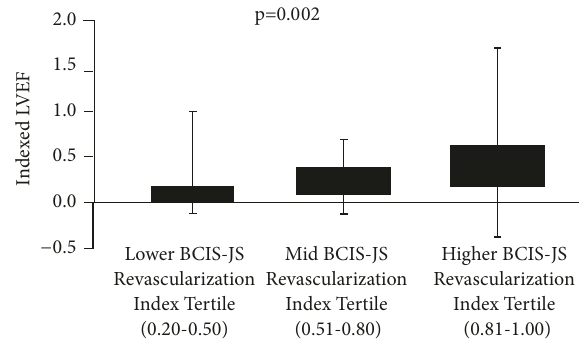
Figure 3: Left ventricular ejection fraction improvement according to revascularization extent . The figure shows the left ventricular improvement in patients stratified according to revascularization extent as evaluated by the British Cardiovascular Intervention Society Jeopardy Score (BCIS-JS) tertiles. LVEF=left ventricular ejection fraction.